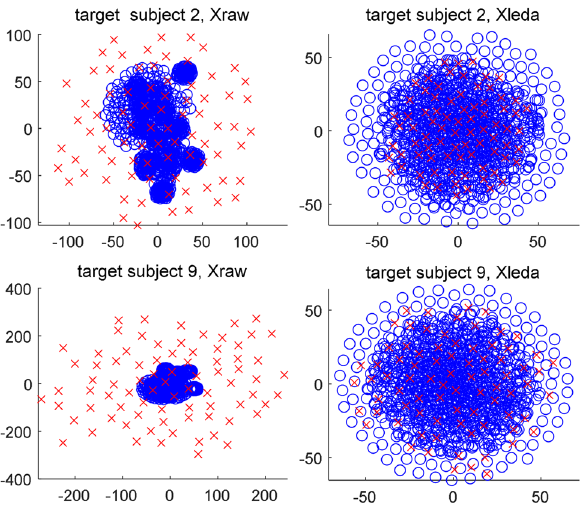
Figure 3. t-SNE visualization of the distribution of raw data (Xraw, the first column) and aligned data by LEDA (Xleda, the second column). The red symbols ‘ × ’ denote the EEG trials from the target subject (16 × 5 = 80 trials), whereas the blue symbols ‘o’ stand for the EEG trials from all source subjects (80 × 15 = 1200 trials).